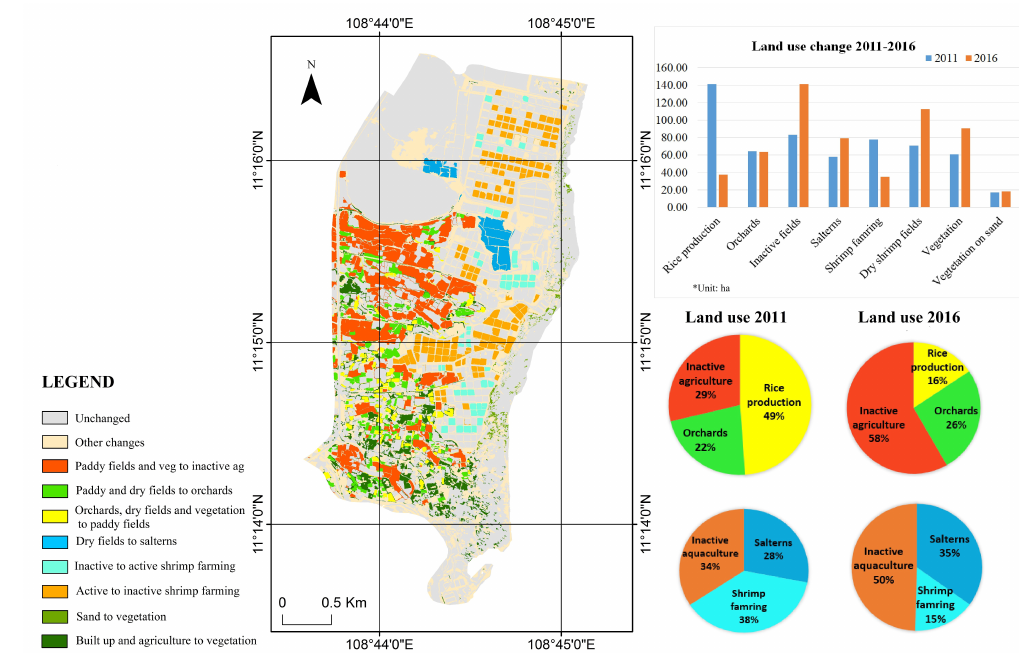
Figure 12. Land use change map of Phuoc The commune during 2011–2016. Bar graph and pie charts describe changes of eight specific classes regarding agriculture, shrimp farming and vegetation